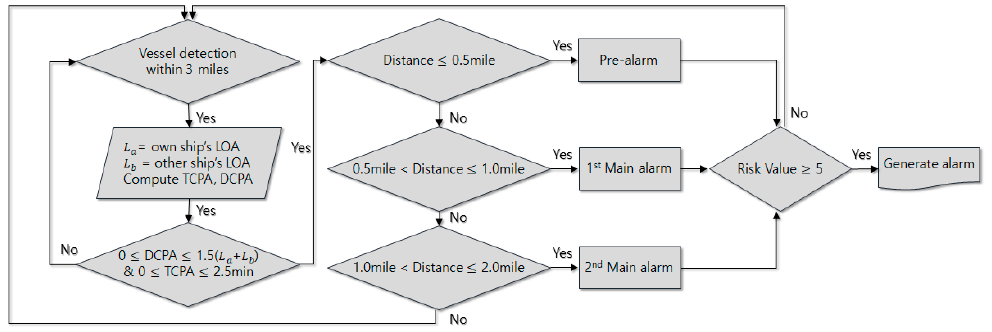
Figure 2. Overview of the collision warning algorithm for small fishing